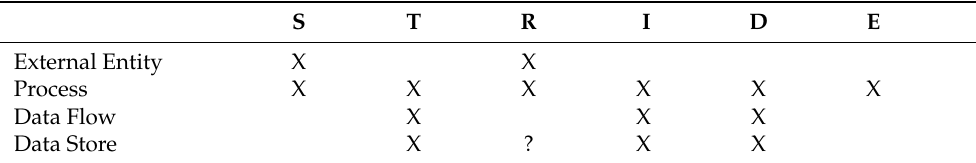
Table 1. Microsoft’s STRIDE-Per-Element